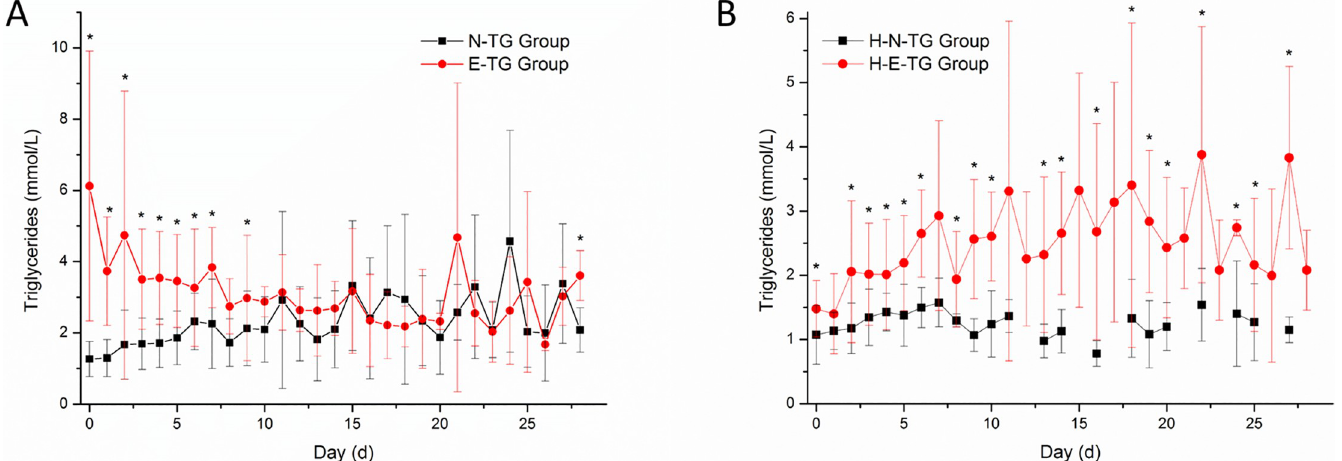
Fig 3. A: Changing trend of serum TG level in N-TG and E-TG group after admission over time. A statistically significant difference was exhibited between N-TG and E-TG group after admission. � p < 0.05. B: Changing trend of serum TG level in H-N-TG and H-E-TG group after admission over time. A statistically significant difference was exhibited between H-N-TG and H-E-TG group after admission. � p < 0.05.